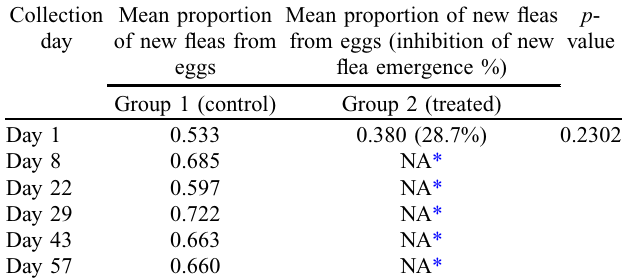
3. Frontline Tri-Act (cid:2) /Frontect (cid:2)